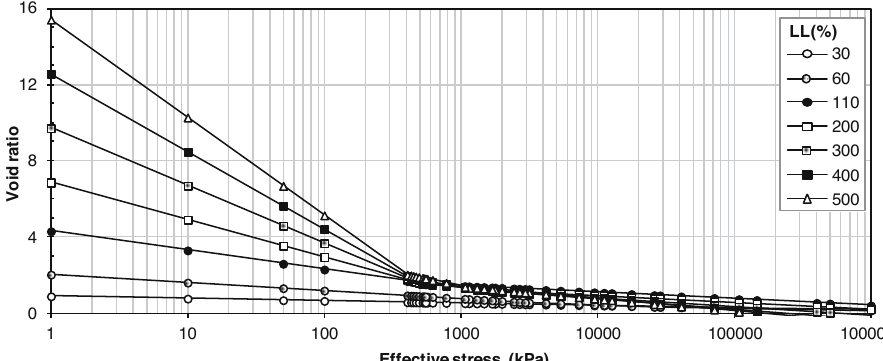
Figure 13: 2D predicted 1D - NCL ’ s for large stresses vs